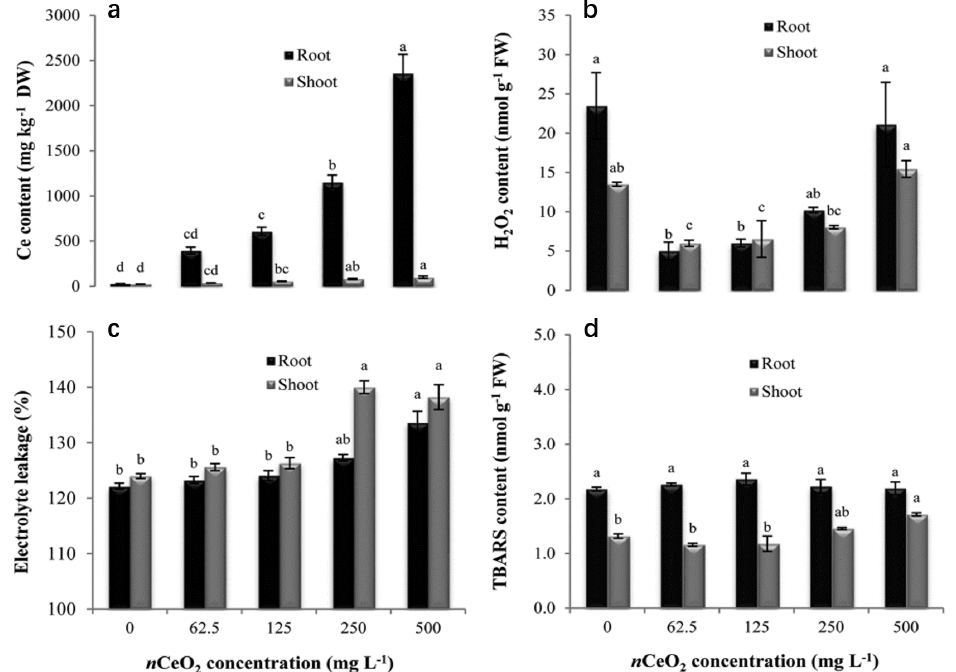
Figure 10. Cerium concentration ( a ), H 2 O 2 generation ( b ), electrolyte leakage ( c ), and TBARS contents ( d ) in seedling tissues of a high amylose rice variety germinated and grown in nCeO 2 suspensions for 10 days. Means with the same letter are not significantly different at Tukey ’ s test ( p ≤ 0.05). Reprinted with permission from Ref. [83]. 2021, American Chemical Society.